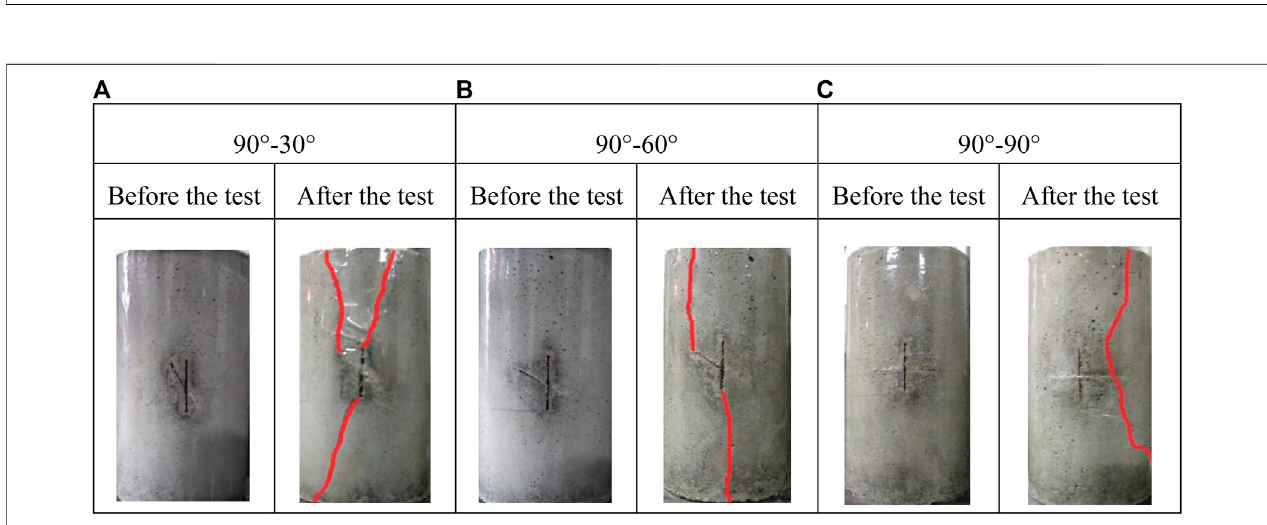
FIGURE 16 | Failure mode of the cracked samples for (A) T-shaped cracked sample of 90 ° – 30 ° , (B) T-shaped cracked sample of 90 ° – 60 ° , (C) T-shaped cracked sample of 90 ° – 90 ° .